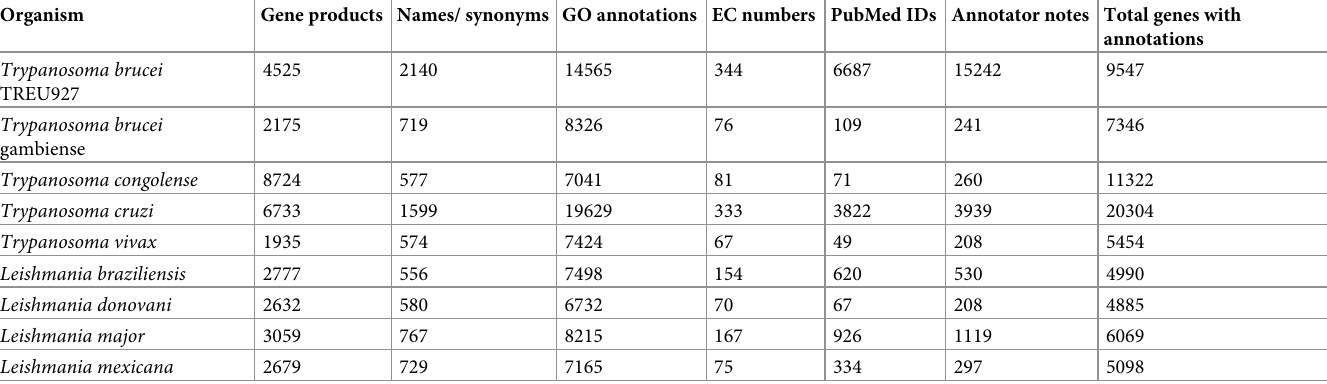
Table 3. Summary of functional annotation updates for curated organisms since the initial integration of genomes in TriTrypDB.